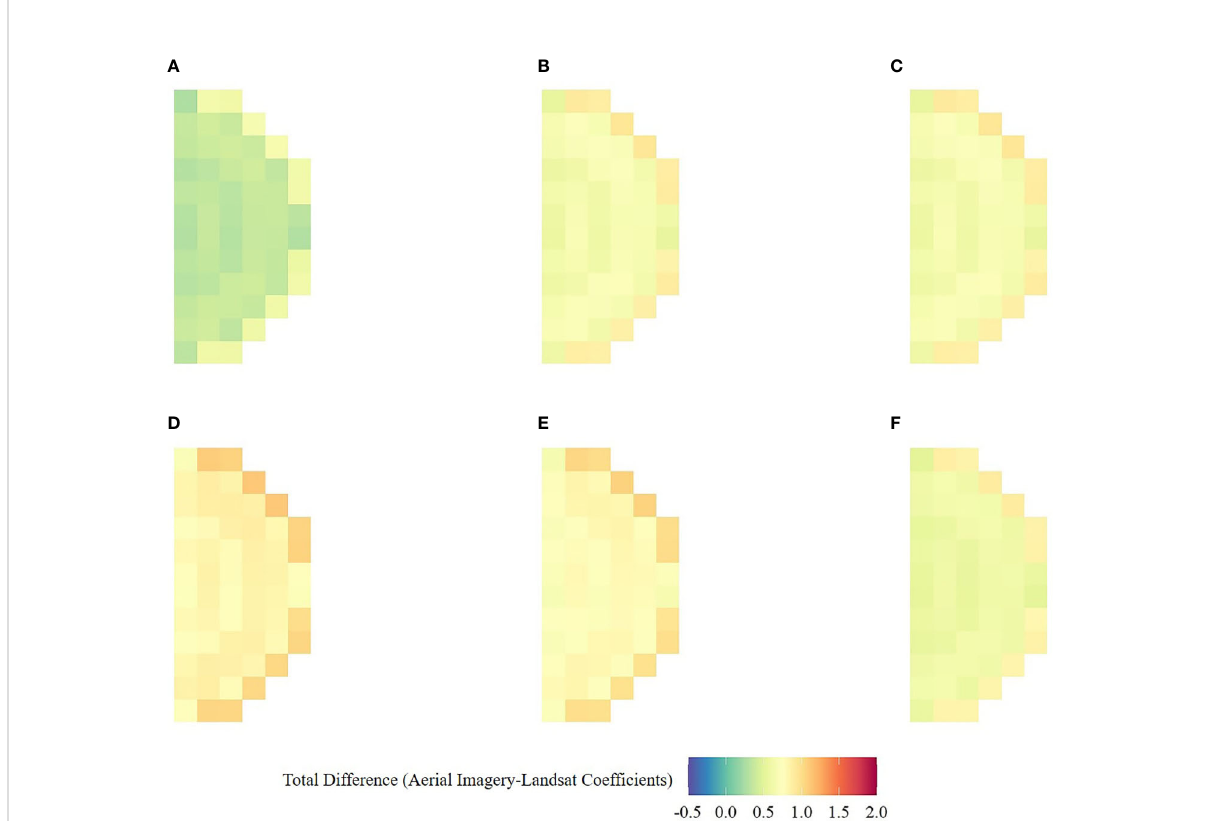
FIGURE 4 Total seasonal differences between the Aerial Imaging crop coef fi cients and the Landsat Fractional ET Data at Field (A) Aerial Imaging crop coef fi cients were estimated from equations developed by (A) Kamble et al. (2013), (B) Bausch and Neale (1987), (C) Bausch and Neale (1987), (D) Bausch (1993), (E) Campos et al. (2017), and (F) Neale et al.,